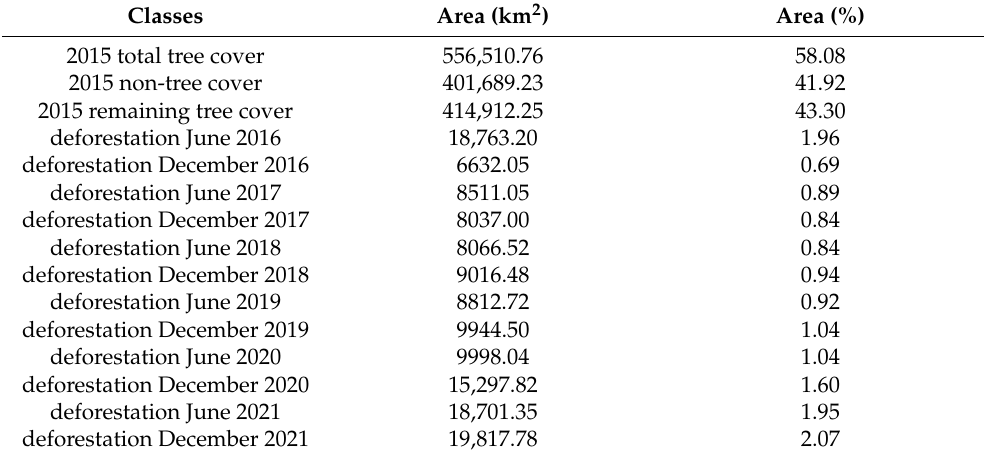
Table 1. Tree cover and its change due to deforestation in the period from 1 December 2015 to 1 December 2021 obtained with planet data and the U-net tree cover model. Classes Area (km 2 ) Area (%) 2015 total tree